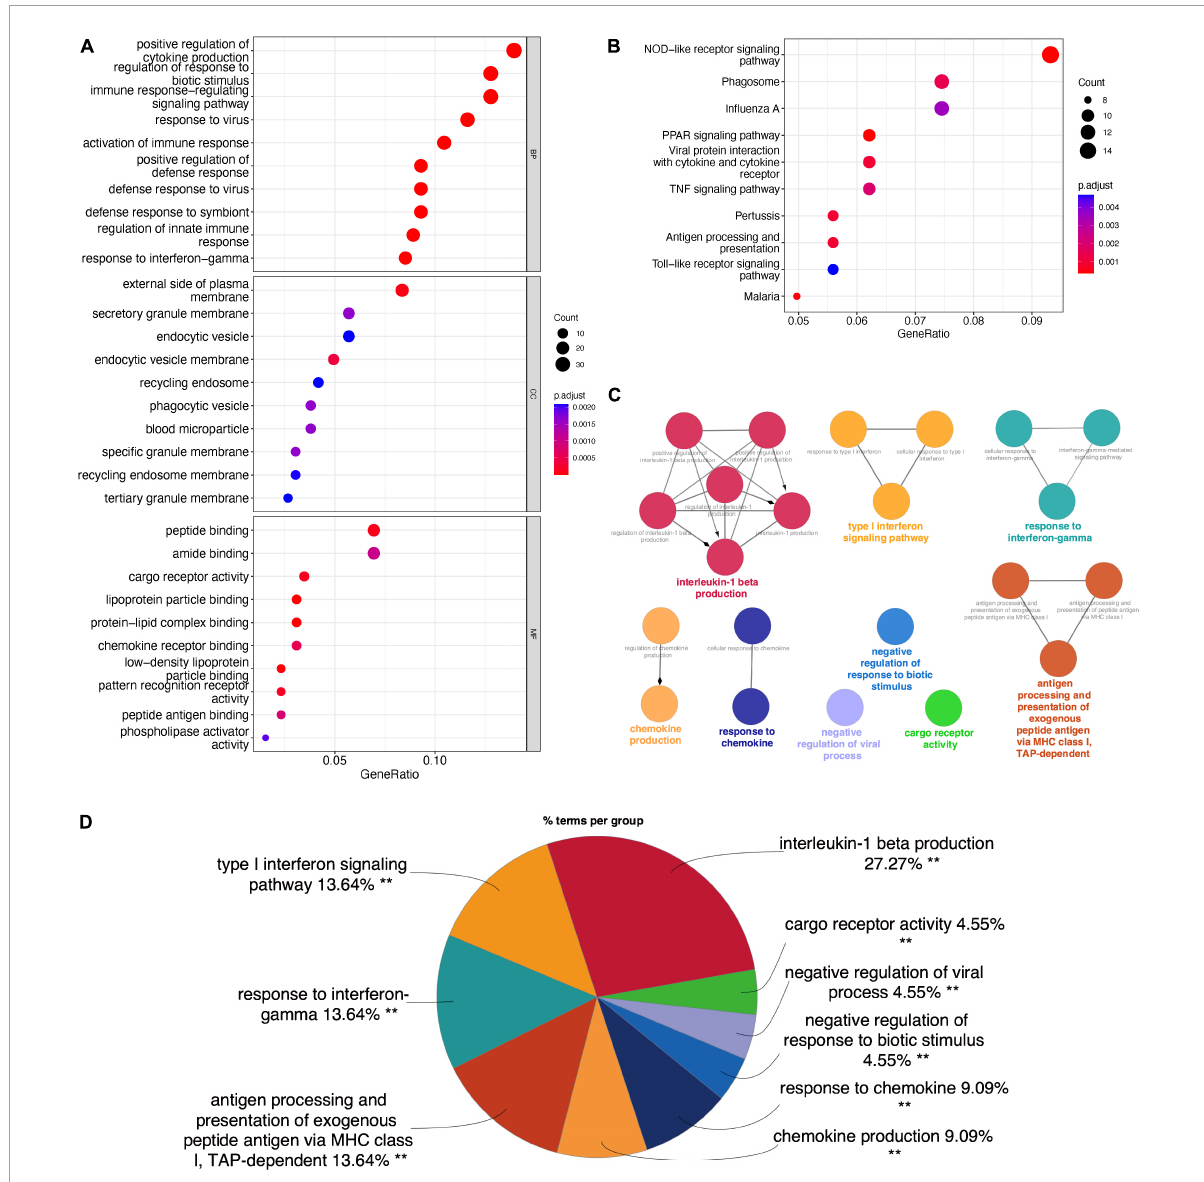
FIGURE2 Enrichment analyses of the overlapping DEGs in M1-polarized datasets. (A) GO enrichment analysis of the overlapping DEGs, at three levels: biological process, cellular component, and molecular function. (B) KEGG pathway analysis of the overlapping DEGs. (C) The interaction network of GO terms, the significant term of each group was highlighted. (D) The proportion of each GO terms group in the total, ** P < 0.05.